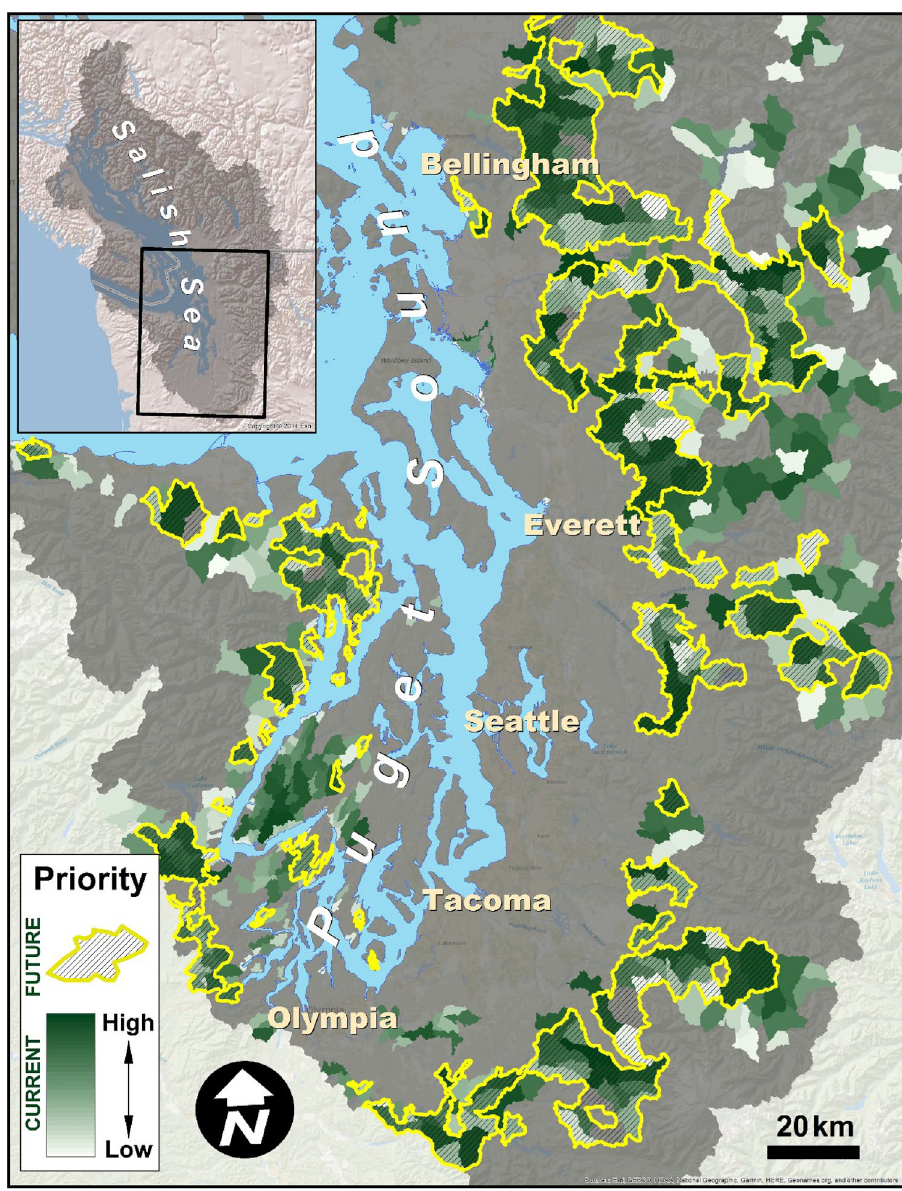
Figure 6. Expected development will increase urbanization impacts to coho habitat. Many subbasins currently identified as high-priority for preservation action (i.e., because predicted pre-spawn mortality is low, shaded in green with darker colors signifying higher priority, as in Figs. 4, 5) are projected to experience ≥ 10% imperviousness by the year 2060 under a status quo future scenario 46 , likely increasing pre-spawn mortality above the critical value of 0.3 (areas outlined in yellow with shading). Map generated using Esri ArcMap software (v. 10.1, https